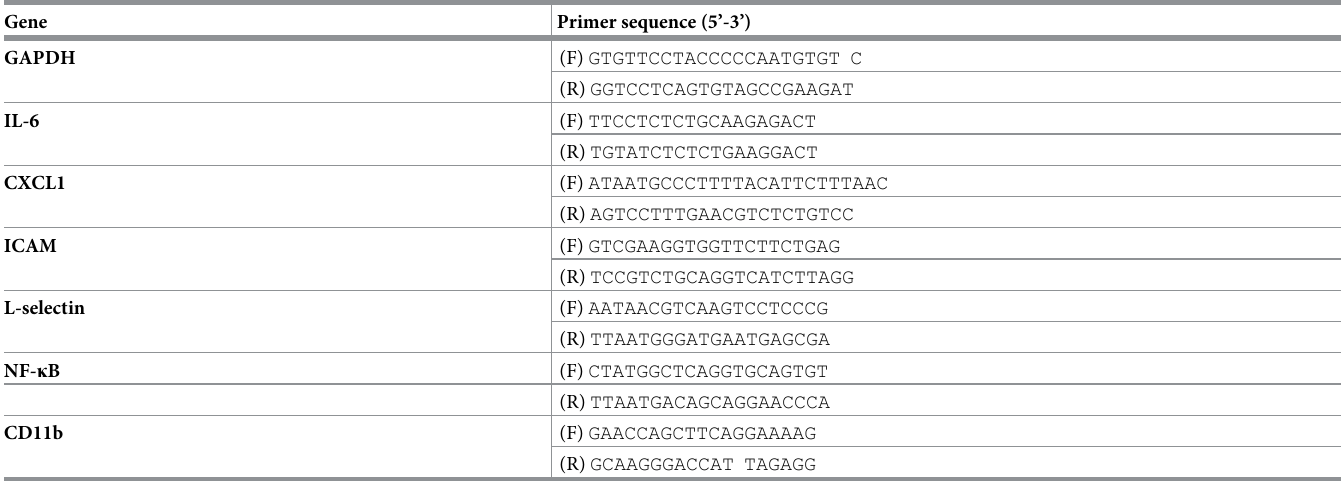
Table 2. Primer sequences used in quantitative real-time PCR.